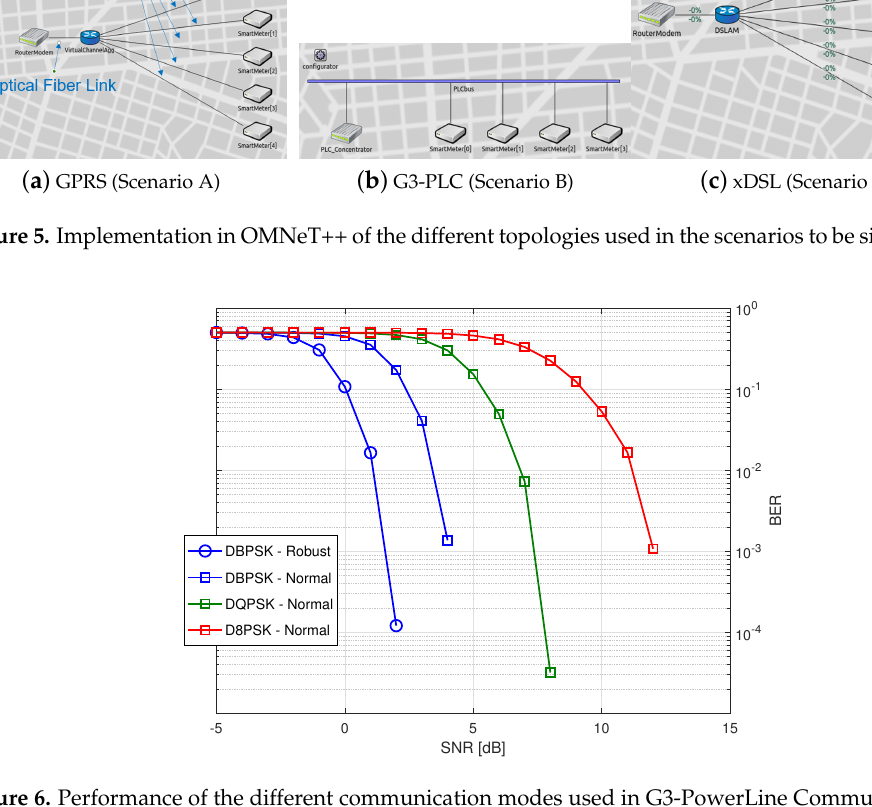
Figure 6. Performance of the different communication modes used in G3-PowerLine Communications (PLC). Adapted from